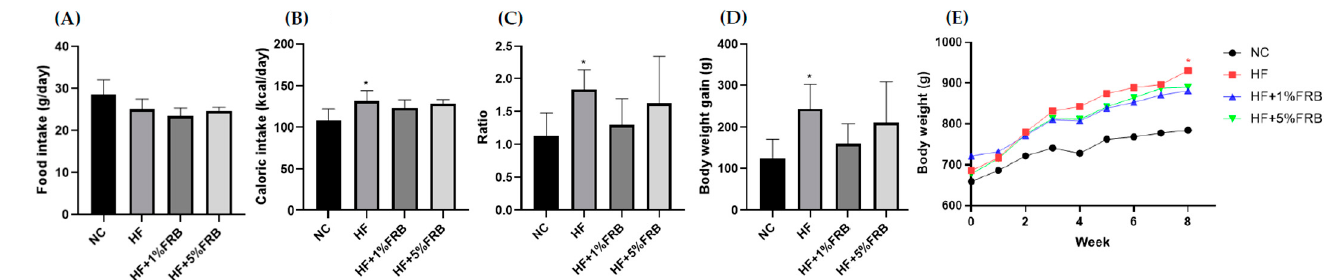
Figure 2. Effects of the water extract of fermented rice bran (FRB) on food intake and body weight in aged rats with high-fat (HF) diet feeding. ( A ) Food intake, ( B ) caloric intake, ( C ) food efficiency ratio (FER), ( D ) body weight gain and ( E ) body weight changes over time. The FER was calculated by applying the equation: FER = (body weight gain (g)/food intake (g)). Values are presented as the mean ± standard deviation ( n = 6). * p < 0.05 vs. the normal control (NC) group; significance between two groups was determined using Student’s t -test. In the HF diet-fed groups, significant differences between groups were determined by a one-way ANOVA with Fisher‘s post hoc test.